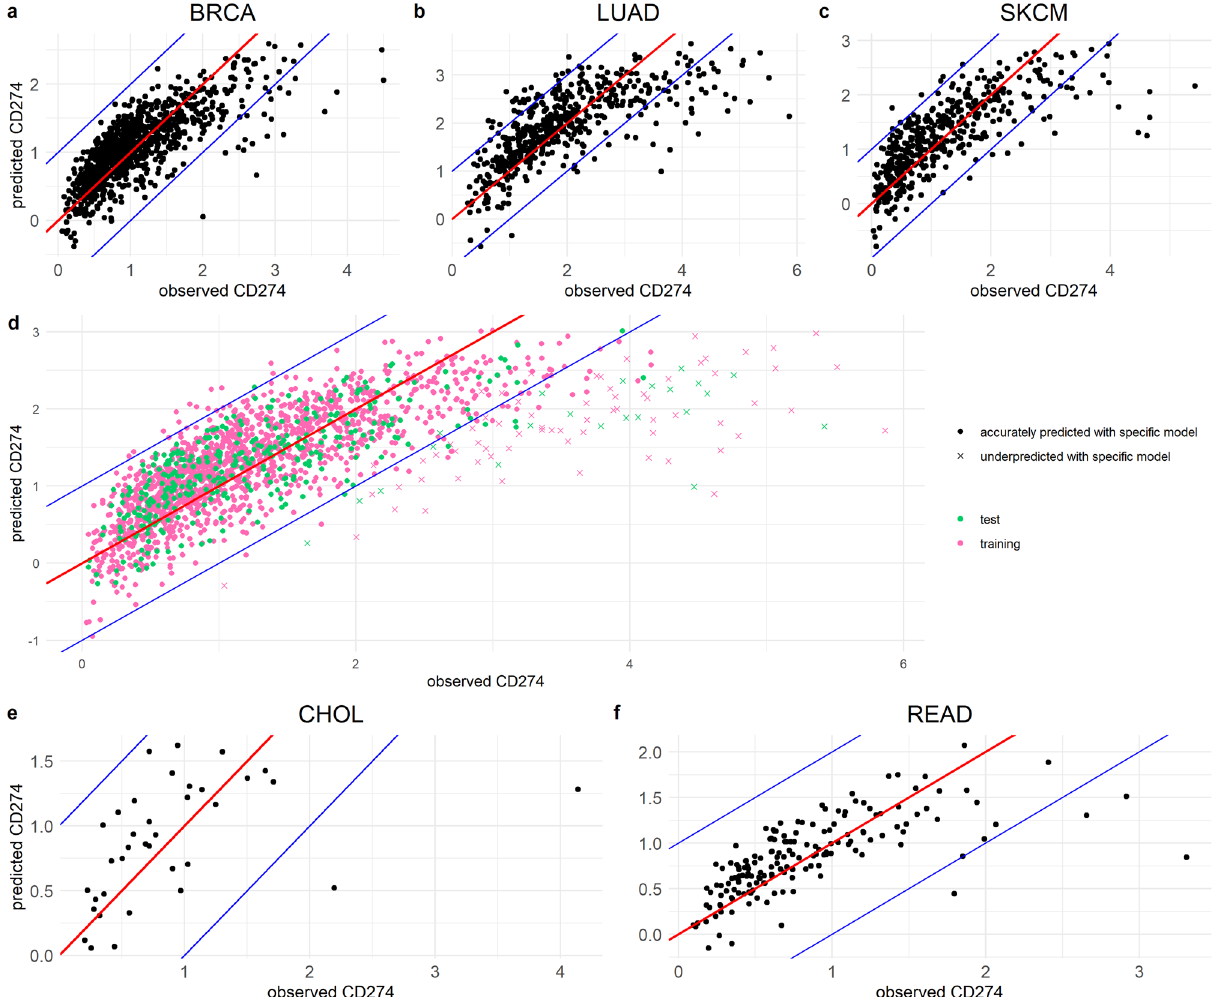
Figure 2. Multiple linear regression models correctly predict CD274 expression based on transcription factor activity in various human cancers. ( a–f ) Comparison of CD274 expression predicted by MLR (vertical axes) and observed CD274 expression (horizontal axes) for BRCA ( a ), LUAD ( b ) and SKCM ( c ) patients, and for a generalized MLR based on a training set of combined BRCA, LUAD and SKCM data applied to a test set of these combined data ( d ), or applied to CHOL ( e ) and READ ( f ) patients. In ( d ), differences compared to the specific models from ( a–c ) are indicated by symbol and